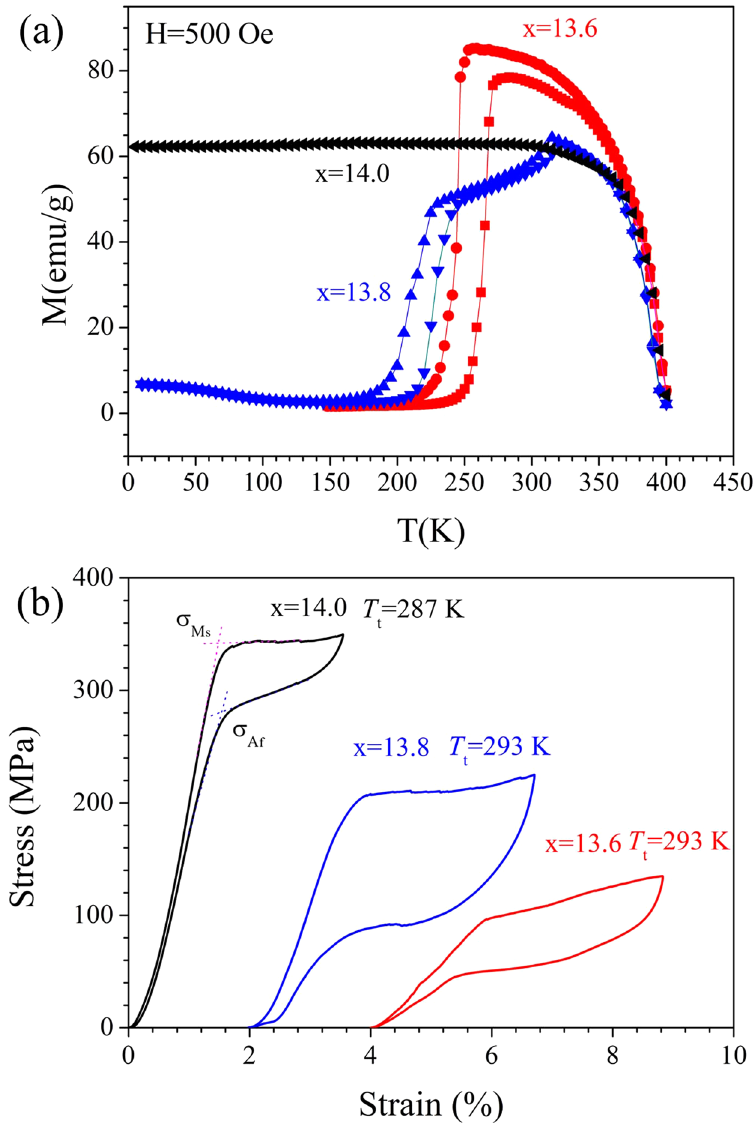
Figure 1. ( a ) Temperature dependence of the magnetization in a magnetic field of 500 Oe for polycrystalline Ni 45 Mn 50 − x In x Co 5 (x = 13.6, 13.8, 14.0) alloys. ( b ) Isothermal stress–strain response upon loading and unloading of Ni 45 Mn 50 − x In x Co 5 (x = 13.6, 13.8, 14.0) samples at a strain rate of 0.0003 s − 1 . The horizontal ordinate is offset by 2% and 4% for x = 13.8 and x = 14.0, respectively.